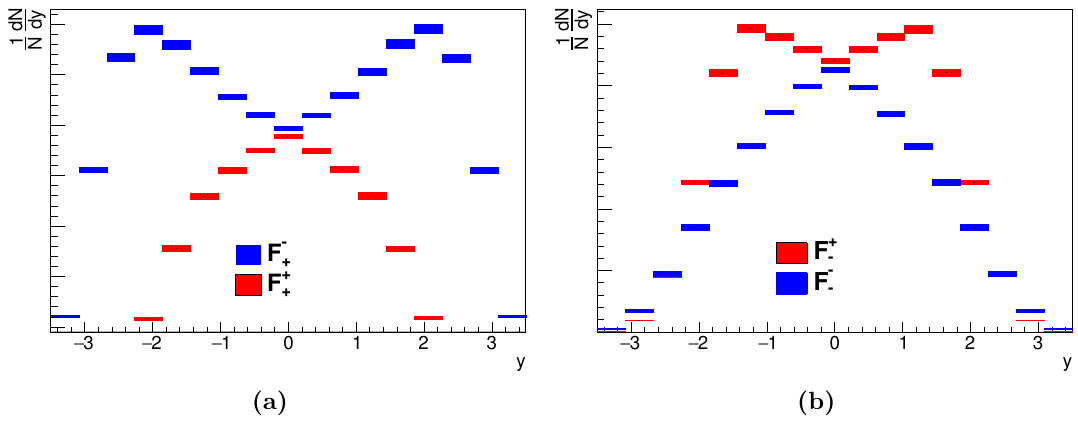
Figure 1 . W rapidity distribution for the positive and negative helicity as computed using the NNPDF3.1 PDFs. a) refers to W + and b) refers to W (cid:0)